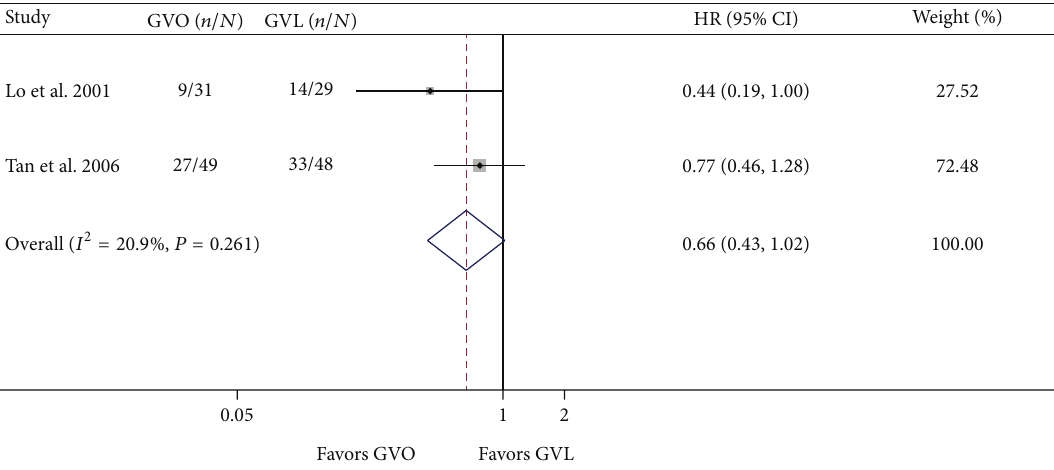
Figure 5: Comparison of mortality in the GVO and GVL groups. GVO, cyanoacrylate injection; GVL, band ligation; CI, confidence interval; OR, hazard